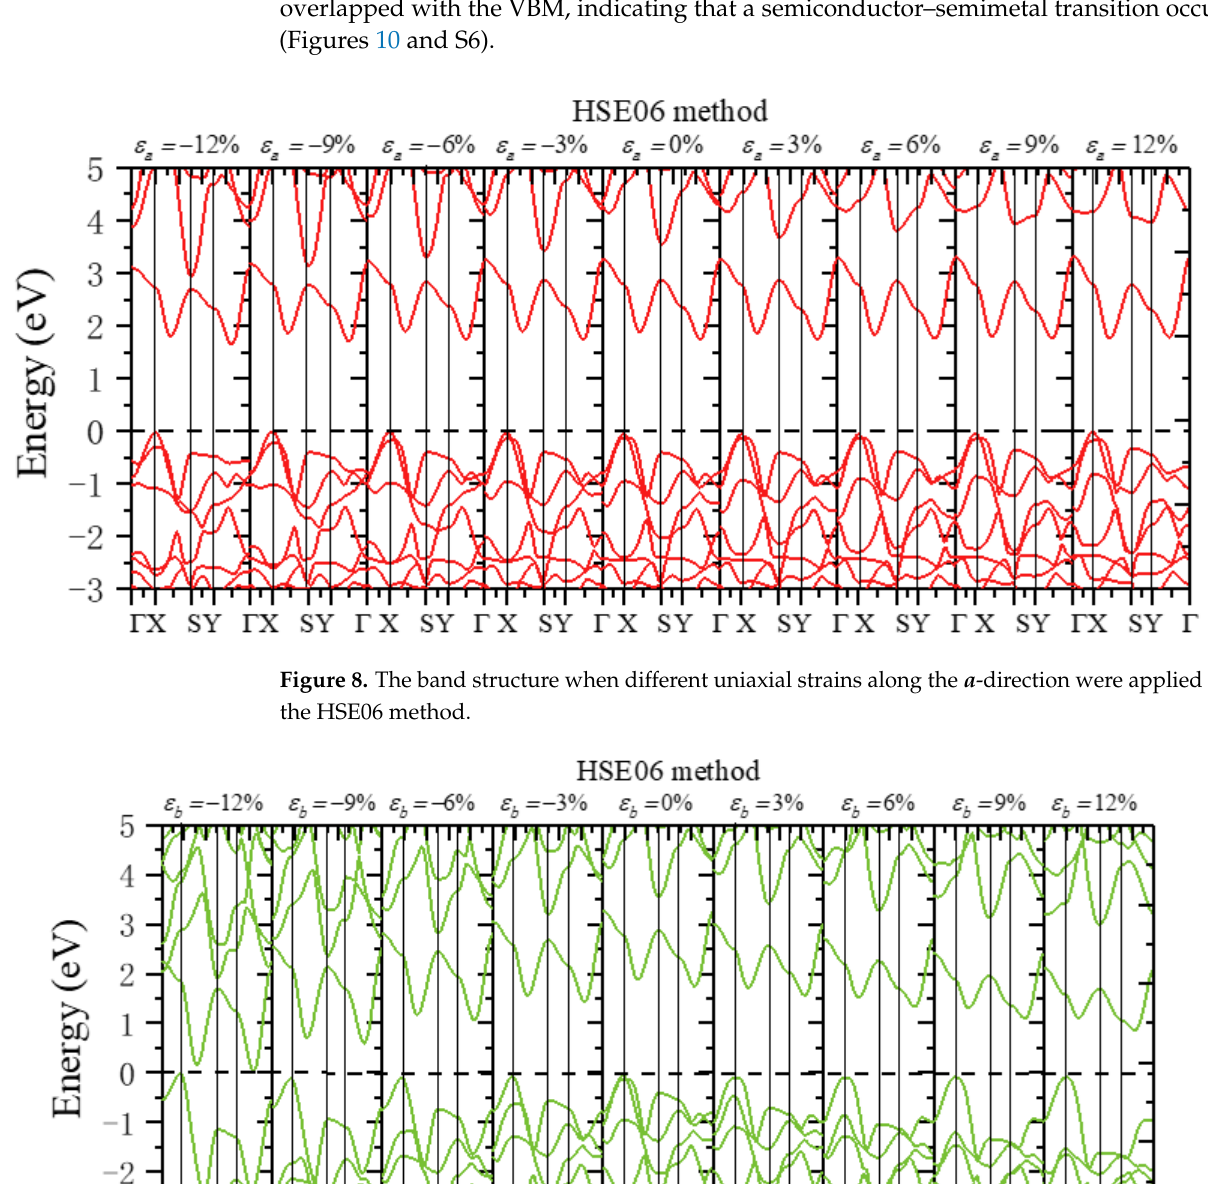
Figure 7. The changes in band gap when different strains were applied: ( a ) under the biaxial strain, ( b ) under the uniaxial strain along the a -direction, and ( c ) under uniaxial strain along the b -direction using the PBE and HSE06 methods.